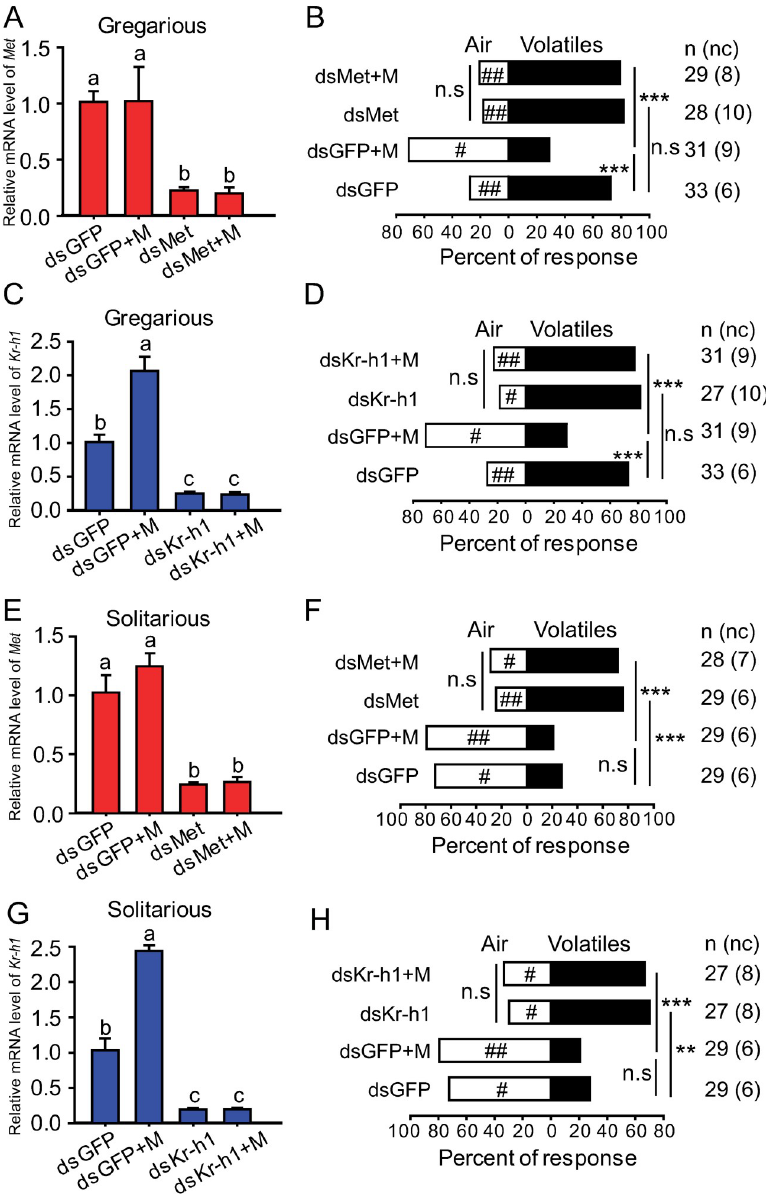
Fig 3. Effects of Met or Kr-h1 RNAi on antennal gene expression and choice behavior in gregarious and solitarious nymphs. (A and B) Relative mRNA level of Met gene and choice behavior after injection of ds GFP or ds Met or rescued by methoprene in gregarious nymphs. (C and D) Relative mRNA level of Kr-h1 gene and choice behavior after injection of ds GFP or ds Kr-h1 or rescued by methoprene in gregarious nymphs. (E and F) Relative mRNA level of Met gene and choice behavior after injection of ds GFP or ds Met or rescued by methoprene in solitarious nymphs. (G and H) Relative mRNA level of Kr-h1 gene and choice behavior after injection of ds GFP or ds Kr-h1 or rescued by methoprene in solitarious